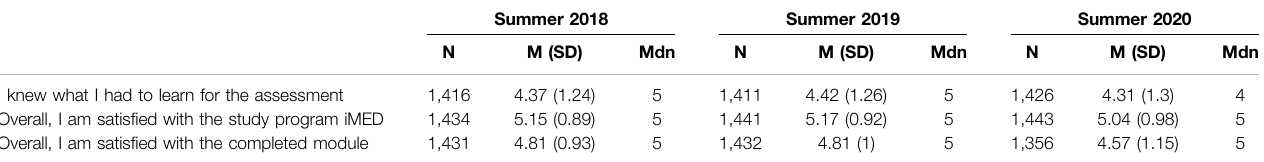
TABLE 3 | Descriptive statistics of study 2.